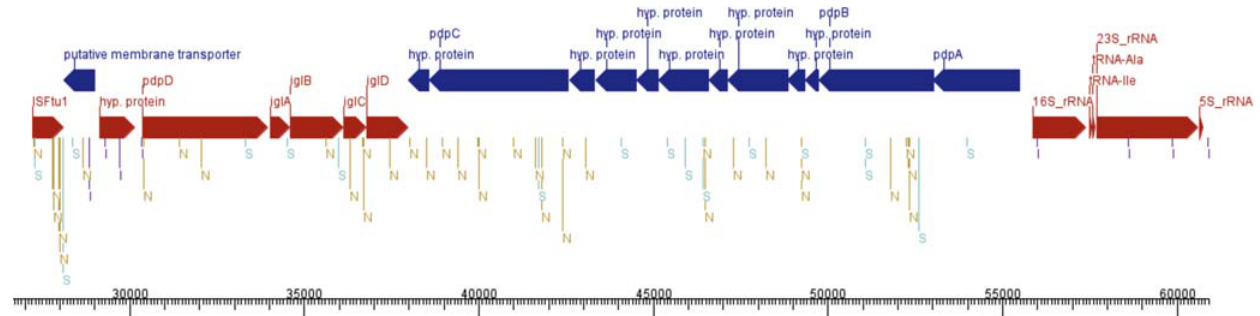
Figure 4. Diagram of the 33,911 bp duplicated region containing the predicted pathogenicity island. SNPs are classified as synonymous (sSNP – light blue), non-synonymous (nSNP - gold), ribosomal (rSNP – green), and intergenic (iSNP - violet). The IglABCD operon is shown in red. SNPs in putative and hypothetical genes are classified as intergenic because their effect is unknown (Table S5).